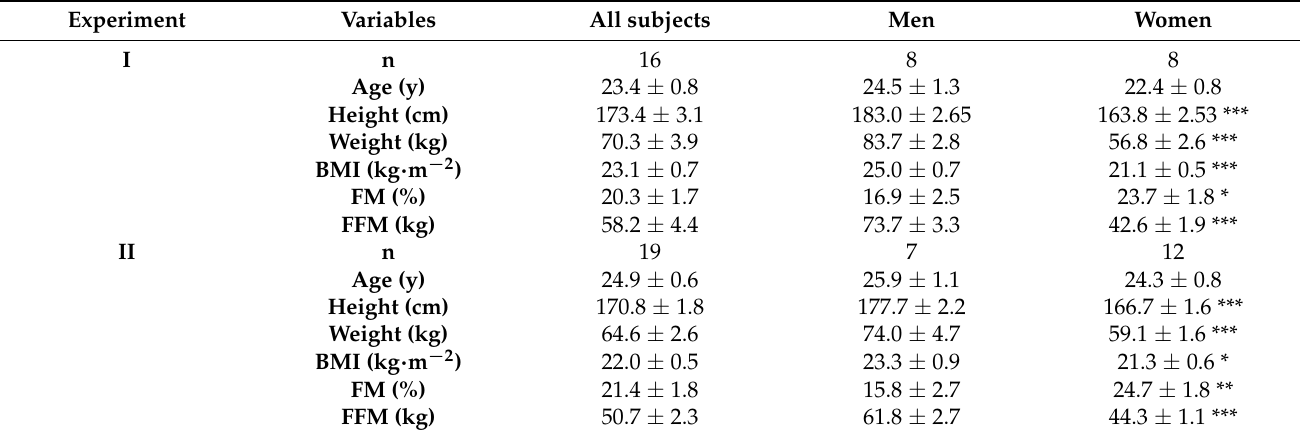
Table 1. General characteristics of the participants in experiments I and